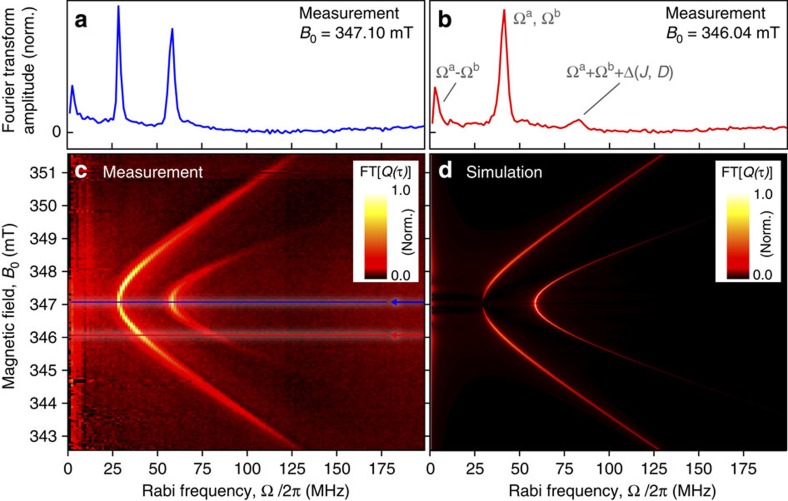
Rabi spin-beat oscillations as a function of B0-detuning in the frequency domain.(a) Rabi frequency components in the on-resonance raw data of Fig. 3a obtained from the Fourier transform of the total charge Q (that is, not the baseline-corrected data ΔQ displayed in Fig. 3). The harmonic is about twice the fundamental frequency, confirming the presence of a strongly driven pair process, where both spins are resonant in the B1 field. A frequency peak due to the difference-beat oscillation is also observed close to the origin. (b) Frequency components under detuning off resonance (obtained from the raw data Q). Fundamental and harmonic shift to higher frequencies under detuning, with the intensity of the harmonic diminishing as only one carrier remains strongly driven. (c) The relative change in frequency and amplitude for continuous detuning. (d) Simulation based on the stochastic Liouville formalism, utilizing the radical pair spin Hamiltonian given in Supplementary Note 1.